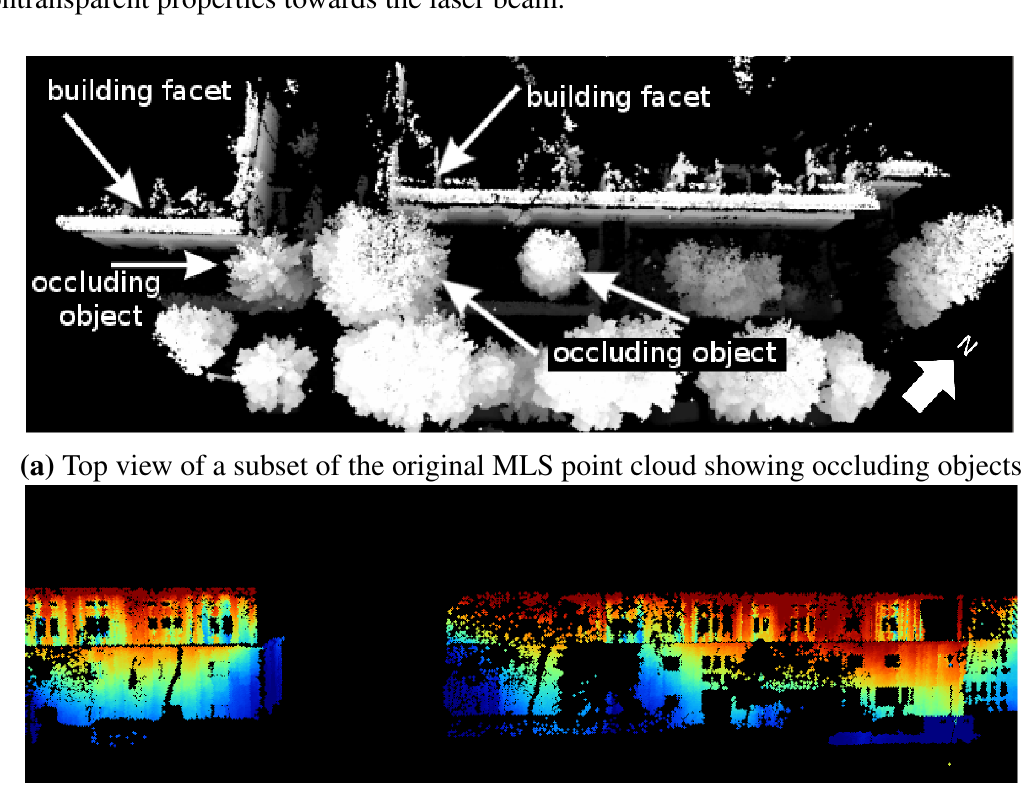
Figure 9. The incoming solar radiation is influenced by surrounding objects: (a) Areas being affected by shadowing effects receive less solar energy than areas that are not occluded by any objects. (b) Occluding objects may also lead to incomplete building facades due to their nontransparent properties towards the laser